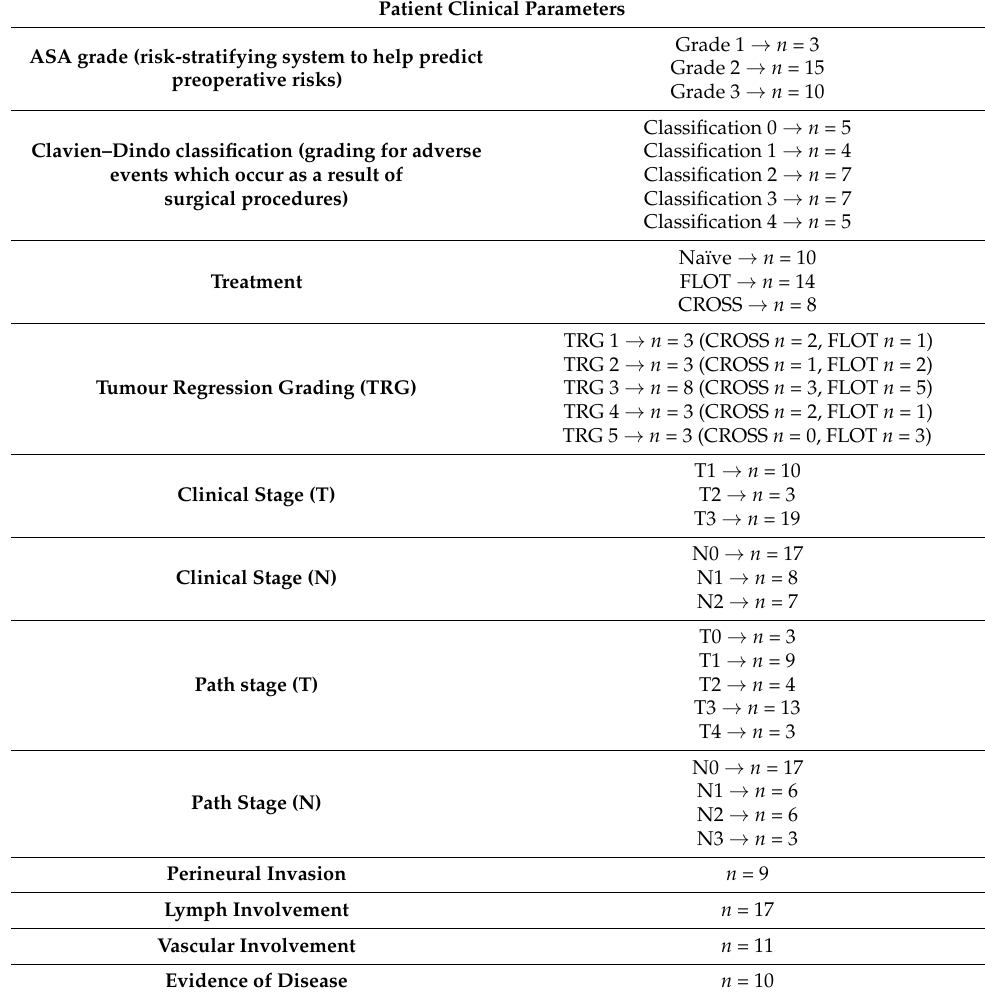
Patient Clinical